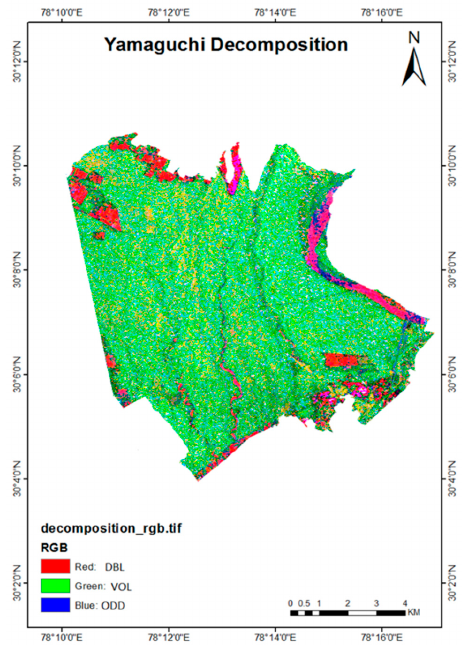
Figure 7. Yamaguchi decomposition of ALOS PALSAR L-band